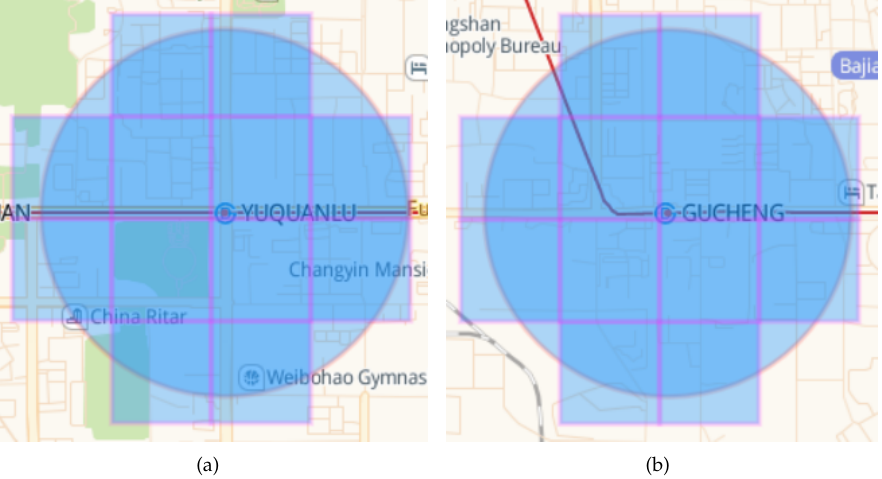
Figure 4. Covered grids by the Pingguo Yuan Station and Gucheng Station. ( a ) Yuquanlu Station; ( b ) Gucheng Station.